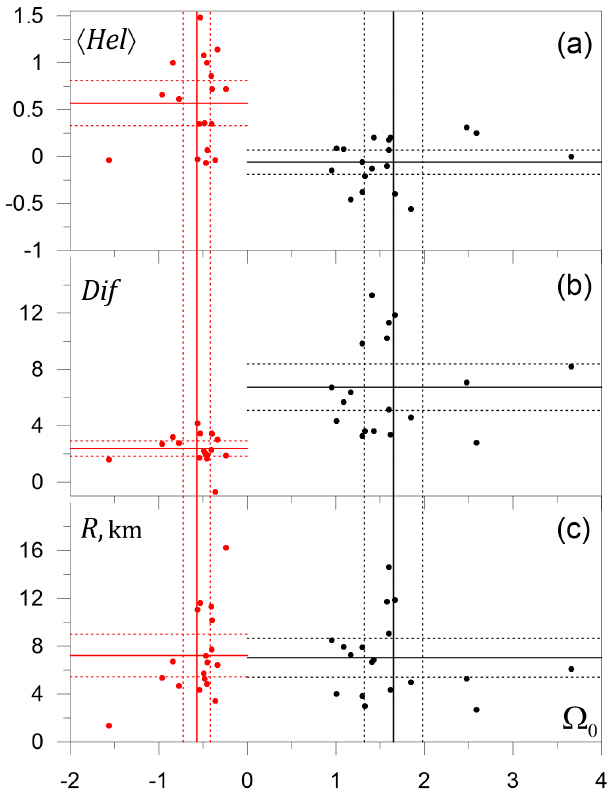
Figure 8. Scatter plots of the helicity (a) , differential rotation (b) parameters and radius (c) of a submesoscale eddy vs. the normal- ized frequency of rotation (cid:127) 0 = 2 ω 0 /f in the eddy center. Hori- zontal and vertical lines are the mean values (solid) and 95% confi- dence limits (dotted) of the parameters calculated separately for the anticyclonic ( (cid:127) 0 < 0, red lines and symbols) and cyclonic ( (cid:127) 0 > 0, black lines and symbols) eddies based on the Student’s t distribu-